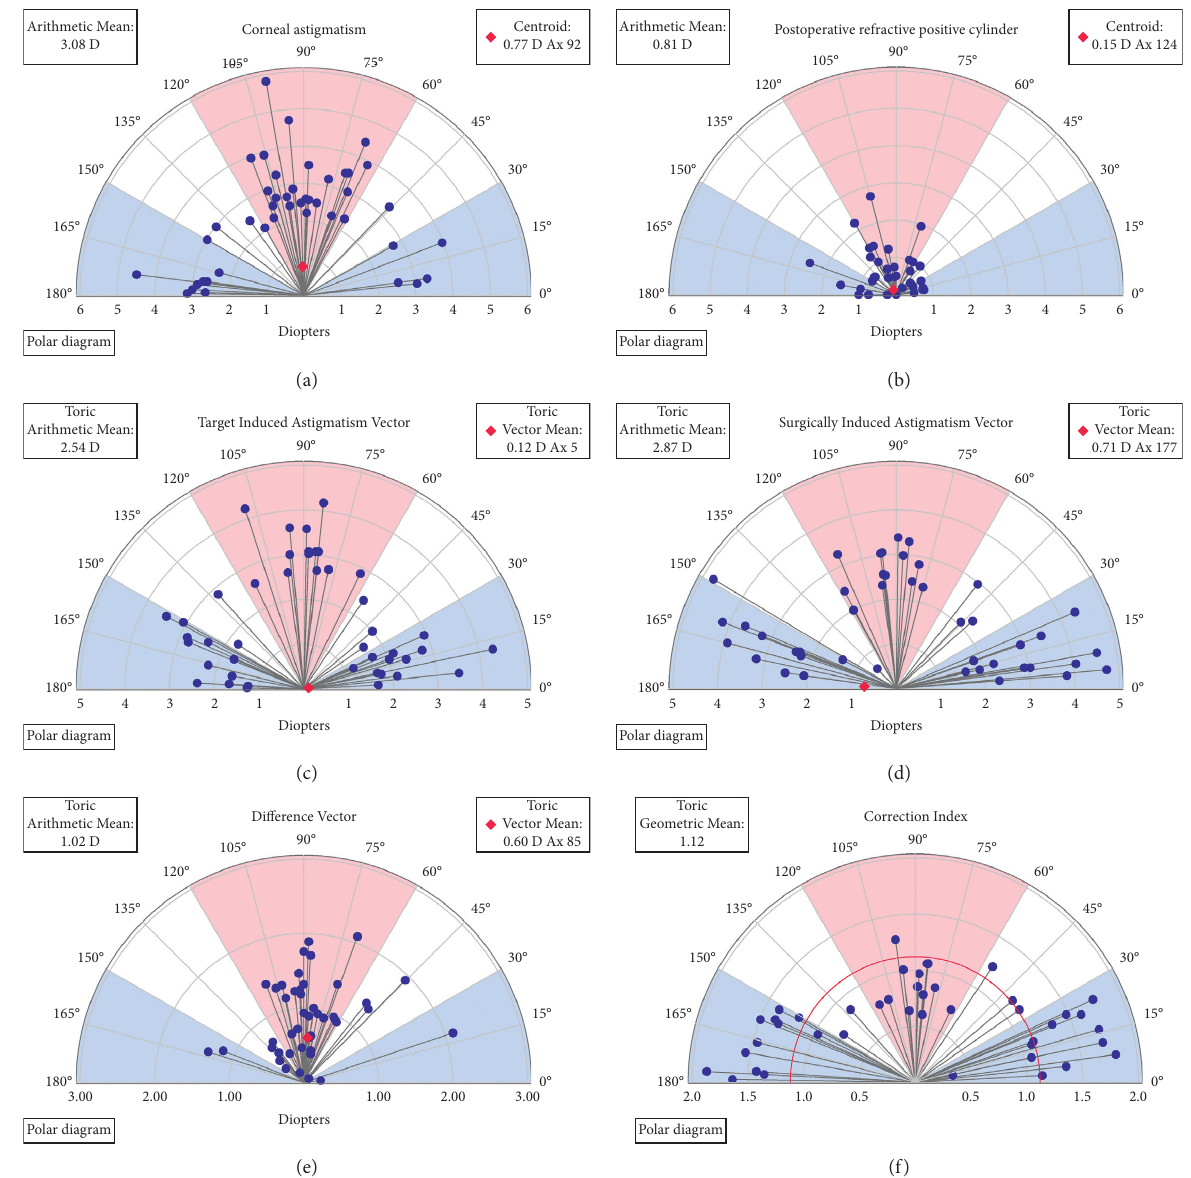
Figure 4: Polar diagrams showing the preoperative corneal astigmatism (a), postoperative refractive positive cylinder (b), target-induced astigmatism vector (c), surgically induced astigmatism vector (d), difference vector (e), and correction index (f). These polar diagrams demonstrate a tendency for overcorrection of with-the-rule astigmatism and undercorrection for against-the-rule